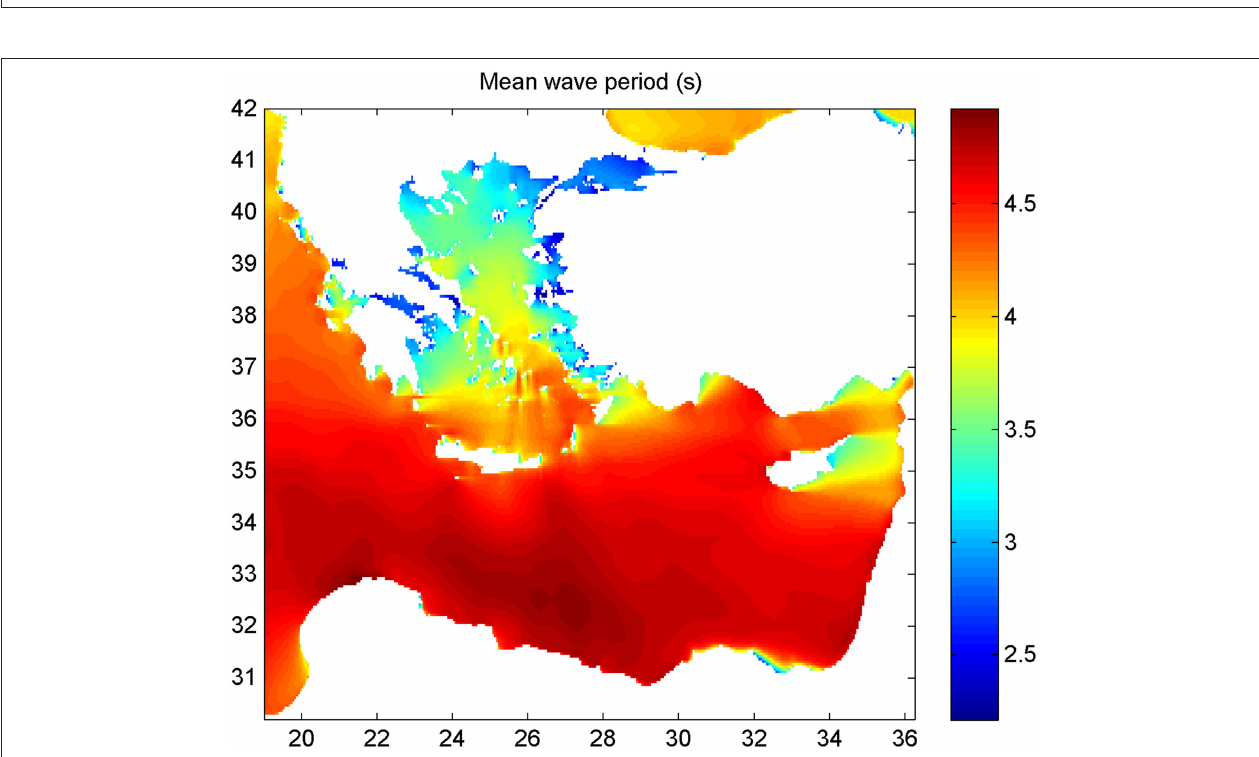
FIGURE 4 | Mean significant wave height for the Eastern Mediterranean during 2010–2017.